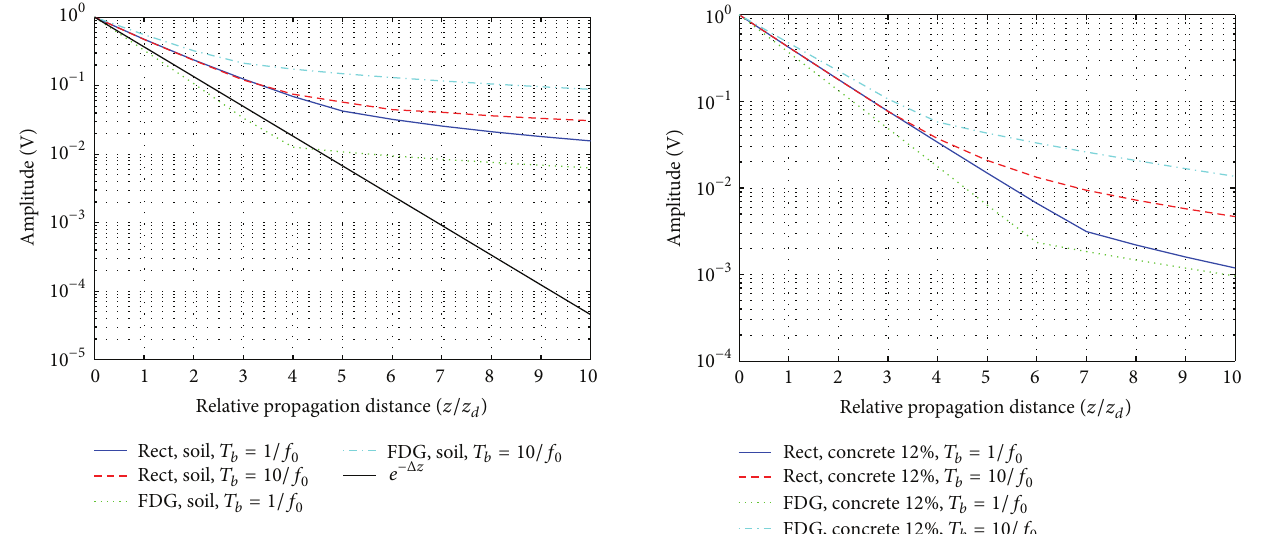
Figure 8: Peak amplitude as a function of propagation distance through soil for rectangular and FDG pulses of duration 𝑇 𝑏 = 10/𝑓 0 and 𝑇 𝑏 = 1/𝑓 0 at 𝑓 0 = 1.5 GHz.